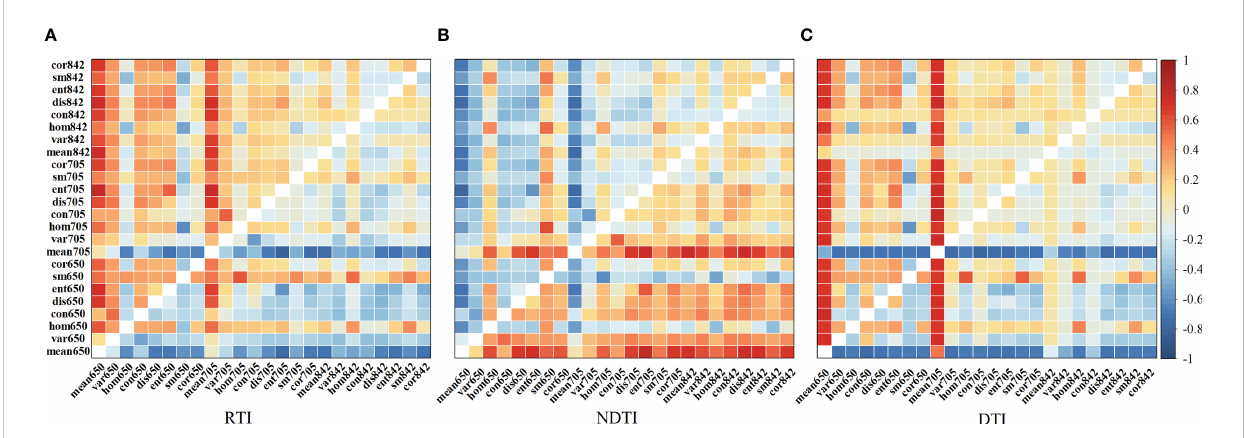
FIGURE 4 Correlation coef fi cient matrix between LAI and three types of texture index indices (A) the ratio texture index, (B) the normalized difference texture index, (C) the difference texture index. Each cell in the fi gure represents the correlation coef fi cient between the texture index, which is obtained by linearly transforming the original texture parameters corresponding to the x and y coordinates of each cell, and the